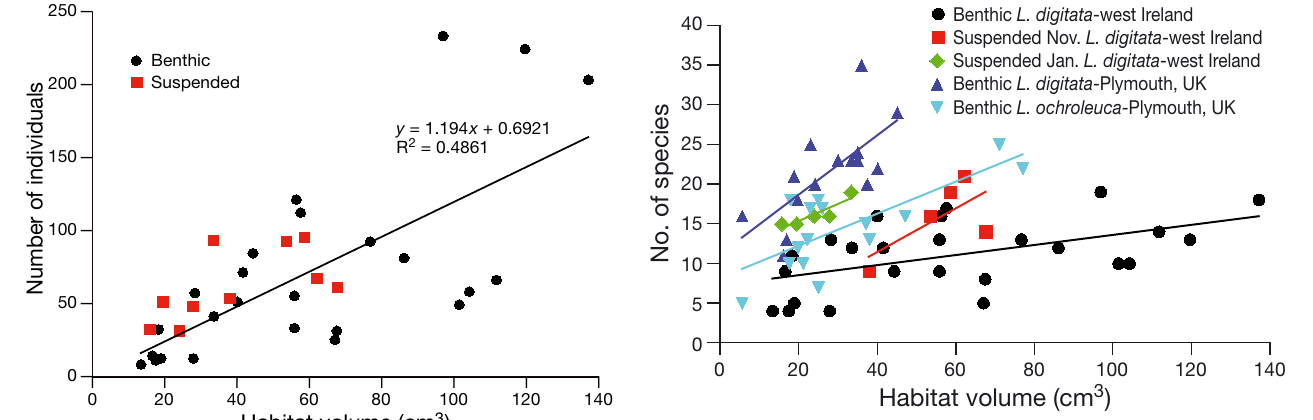
Fig. 5. The relationship between holdfast habitat volume and number of species per holdfast for Blight & Thompson (2008, Plymouth, UK) benthic Laminaria digitata (r 2 = 48%, slope = 0.376, SE = 0.545) and benthic L. ochroleuca (r 2 = 56%, slope = 0.202, SE = 0.262), and, from the current study (west Ireland), benthic L. digitata (r 2 = 27%, slope = 0.063, SE = 0.164), suspended November L. digitata (r 2 = 81%,